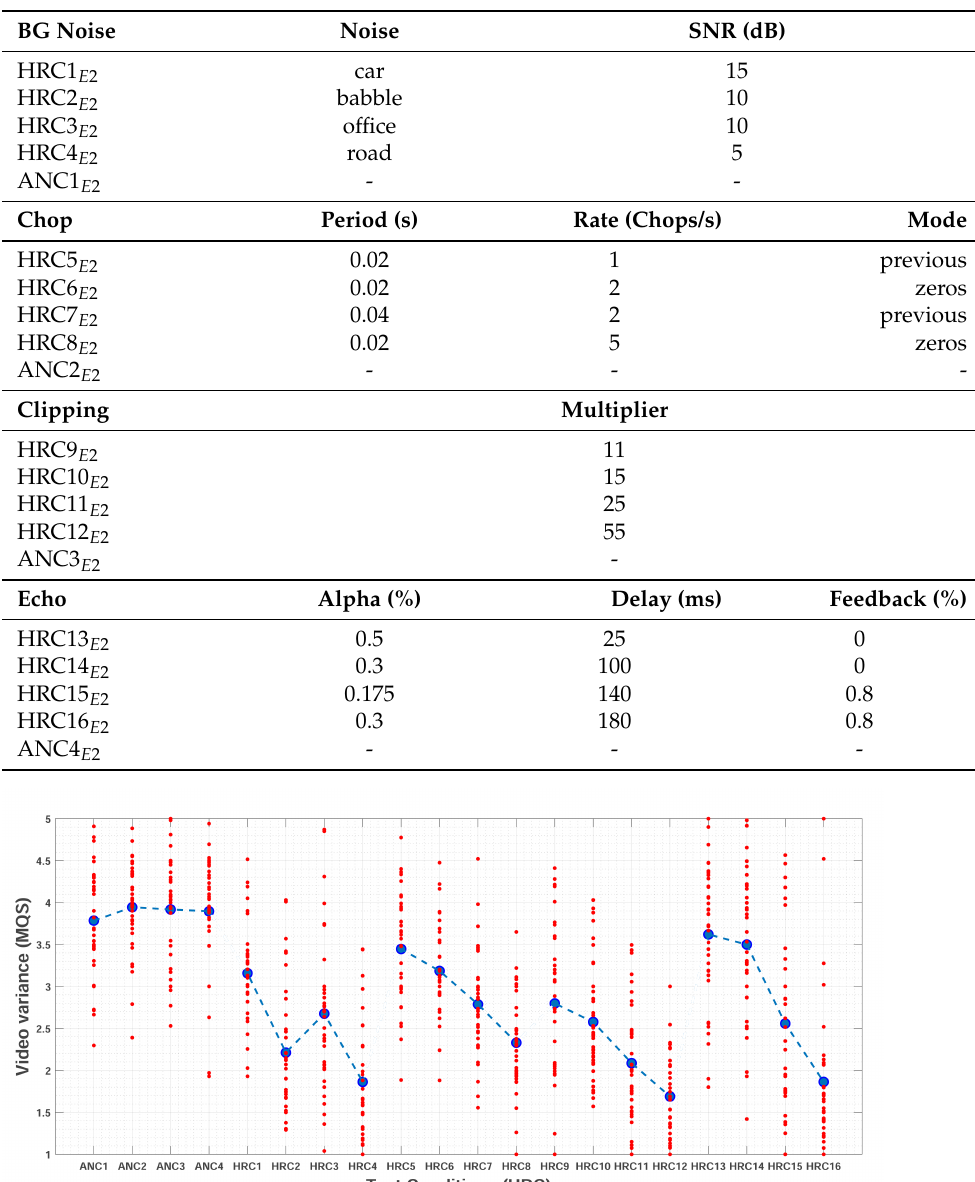
Table 8. HRC and ANC corresponding parameters used in Experiment 2.